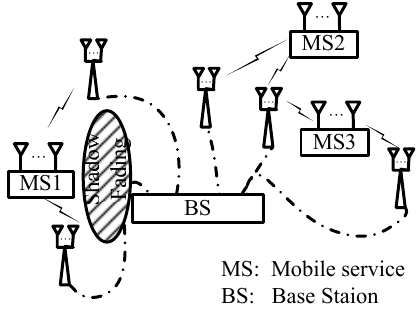
Fig.1 Schematic diagram of distributed MIMO